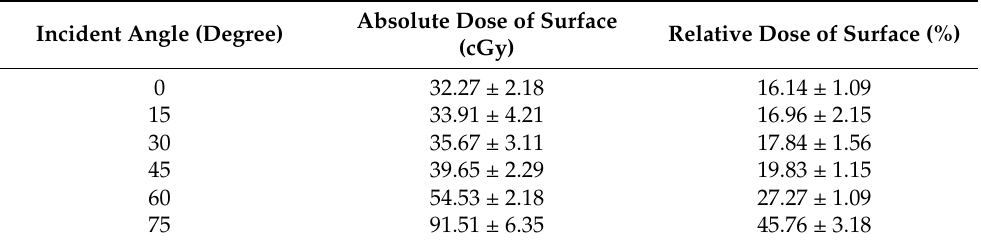
Figure 4. The surface dose by different incident angles. The trend line is a binomial regression, as described above. Table 1. The results of incident angle and surface dose under one direction to the rectangular cuboid phantom. The average of the absolute surface dose is 47.92 ± 3.39 (cGy).